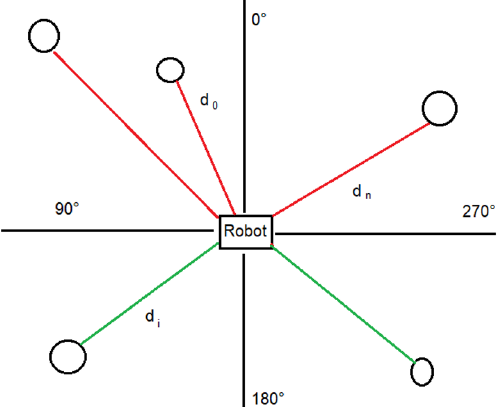
Figure 5. The calculation of safe